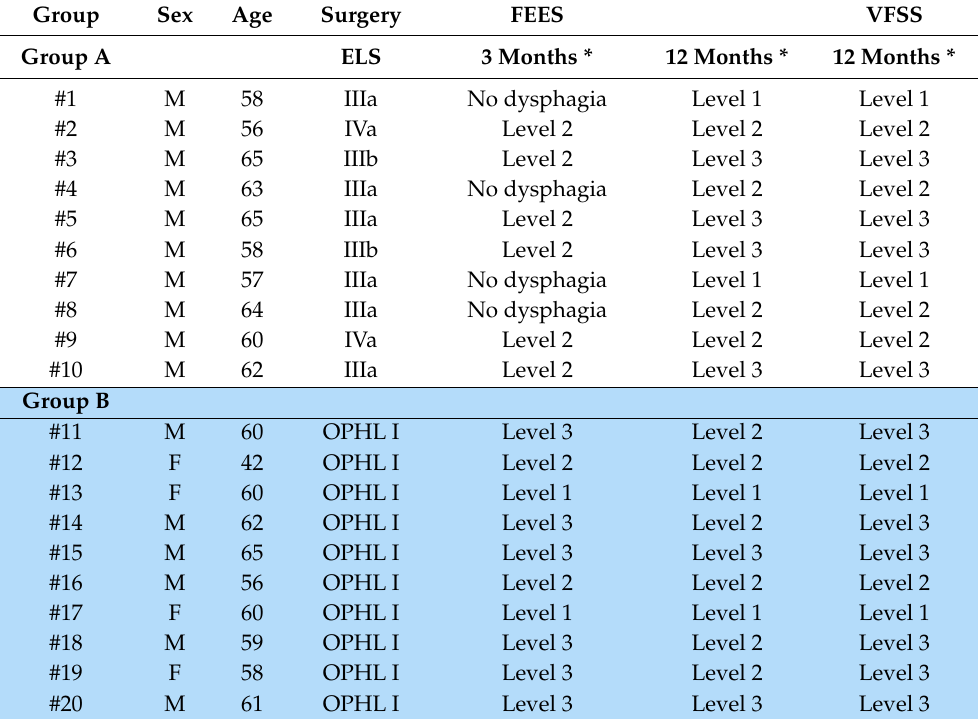
Table 2. FEES and VFSS